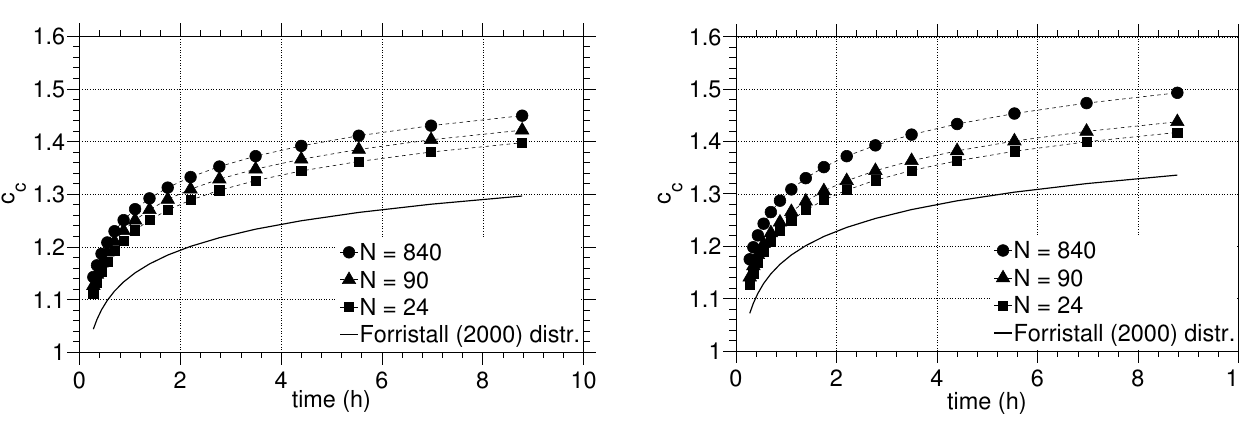
Fig. 10. Wave crest probability as a function of the sea state duration for a nominal sea state with k p H s / 2 = 0 . 16 (experiments). c c here represents the characteristic largest value for the non-dimensional wave crest c r